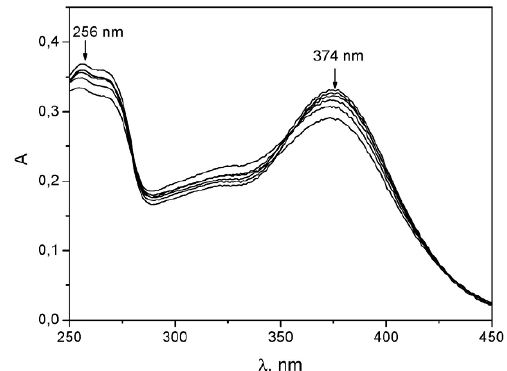
Figure 7. Absorption spectra of 15 µM quercetin taken after 1 min incubation with 40 mM bicarbonate and peroxynitrite at concentrations: 0, 25, 50, 75, 100 and 150 µM, at pH